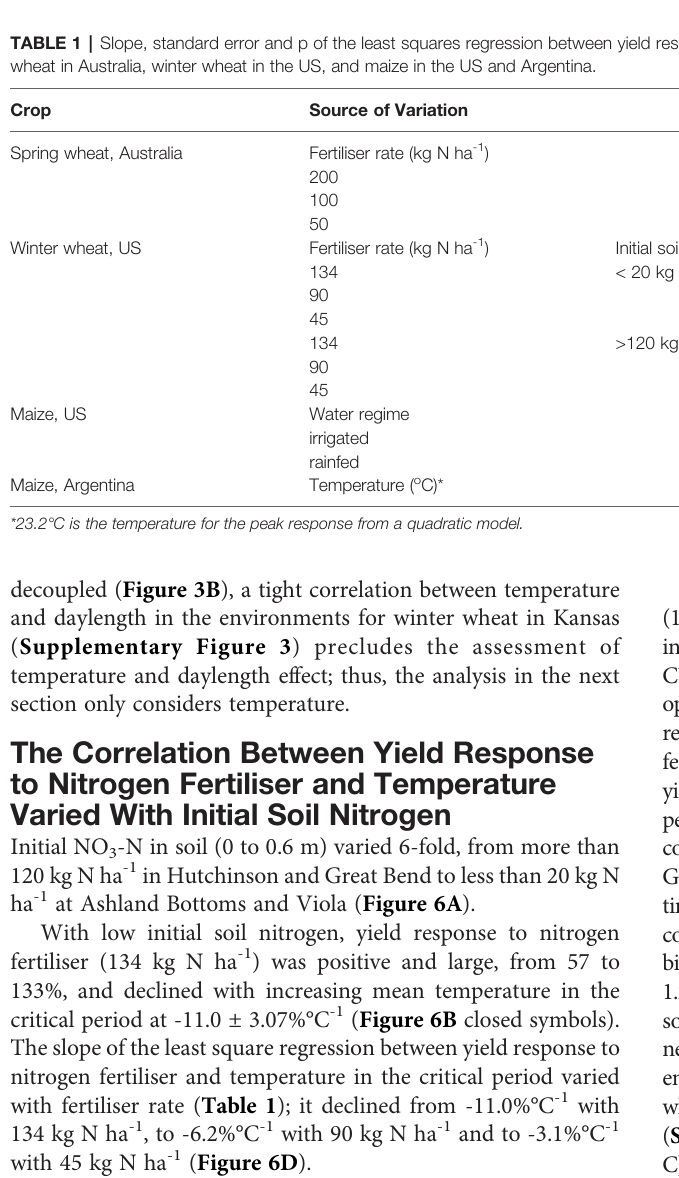
TABLE 1 | Slope, standard error and p of the least squares regression between yield response to nitrogen and mean air temperature in the critical period of spring wheat in Australia, winter wheat in the US, and maize in the US and Argentina. Crop Source of